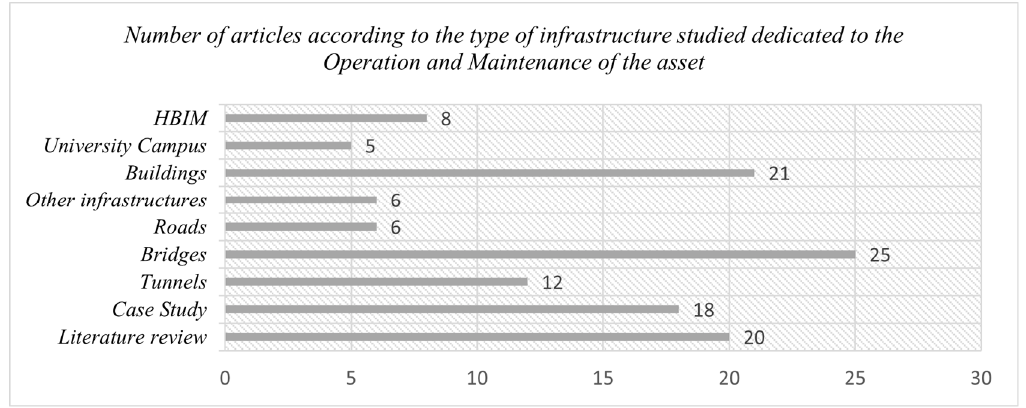
Figure 6. Number of articles according to the type of infrastructure studied dedicated to the operation and maintenance of the asset.